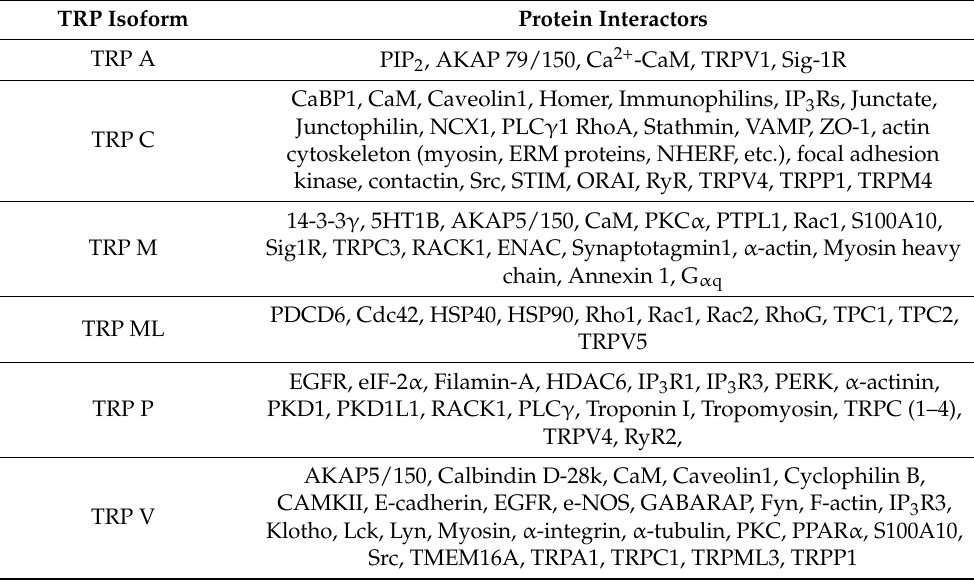
Table 2. Protein interactions of TRP channel